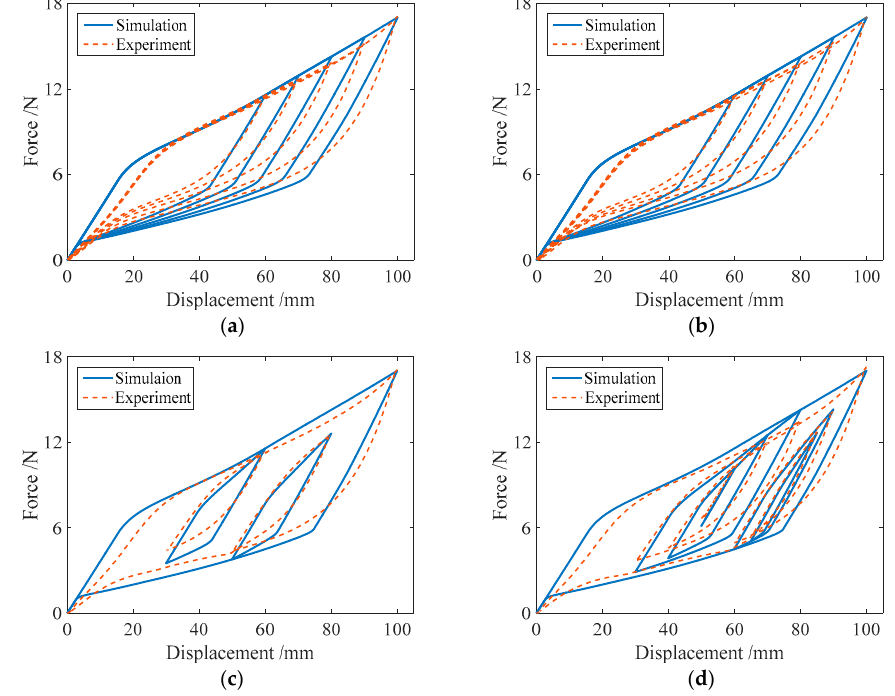
Figure 13. The simulation results of the force-displacement relationship of specimen SMA-S3 in different loading cases: ( a ) Case I; ( b ) Case II; ( c ) Case III; ( d ) Case IV.